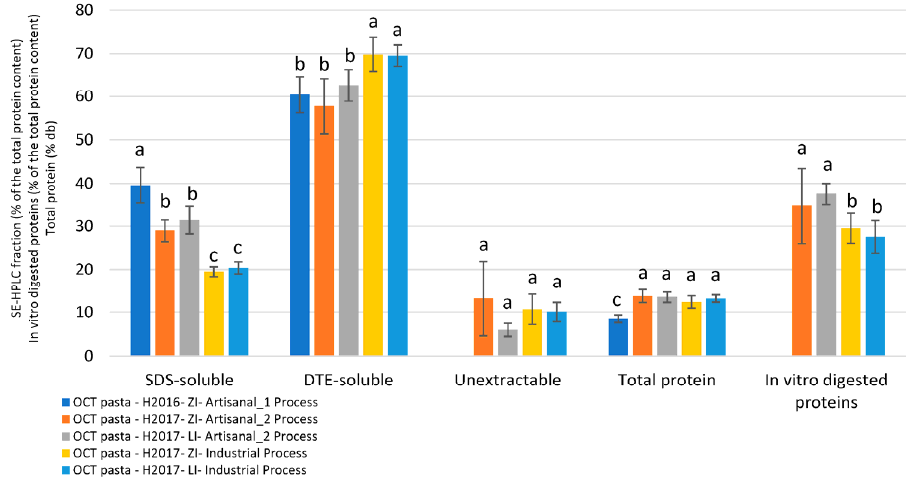
Figure 9. Protein composition measured on freeze-dried OCT cooked pasta from Set 2, using SE- HPLC analysis: SDS-soluble and DTE-soluble proteins (as a percentage of the total protein content), total protein content (% db) and proportion of in vitro-digested proteins (% of the total protein content) according to process and cropping system. Means and error bars (SD). Bar values marked with the same letter are not significantly different based on Student–Newman–Keuls (SNK) test performed at α = 0.05.